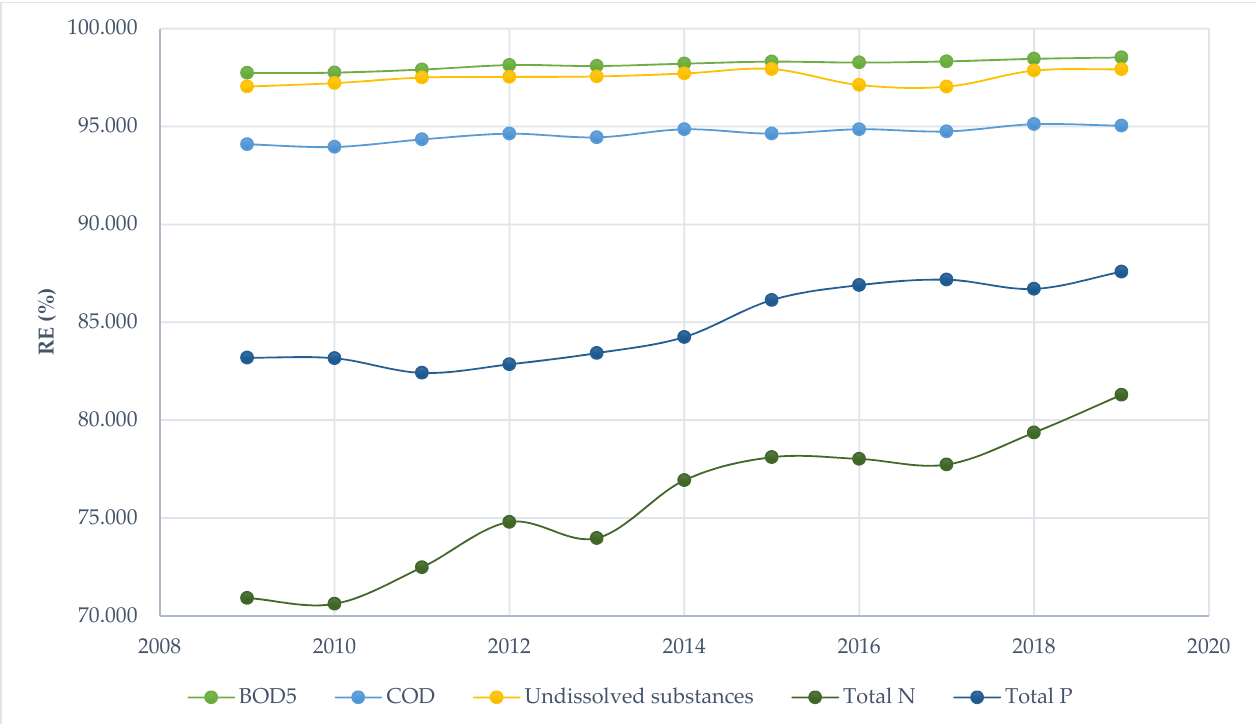
Figure 5. Removal efficiency or load reduction (%) by WWTPs for each parameter in Czechia 2009–2019.